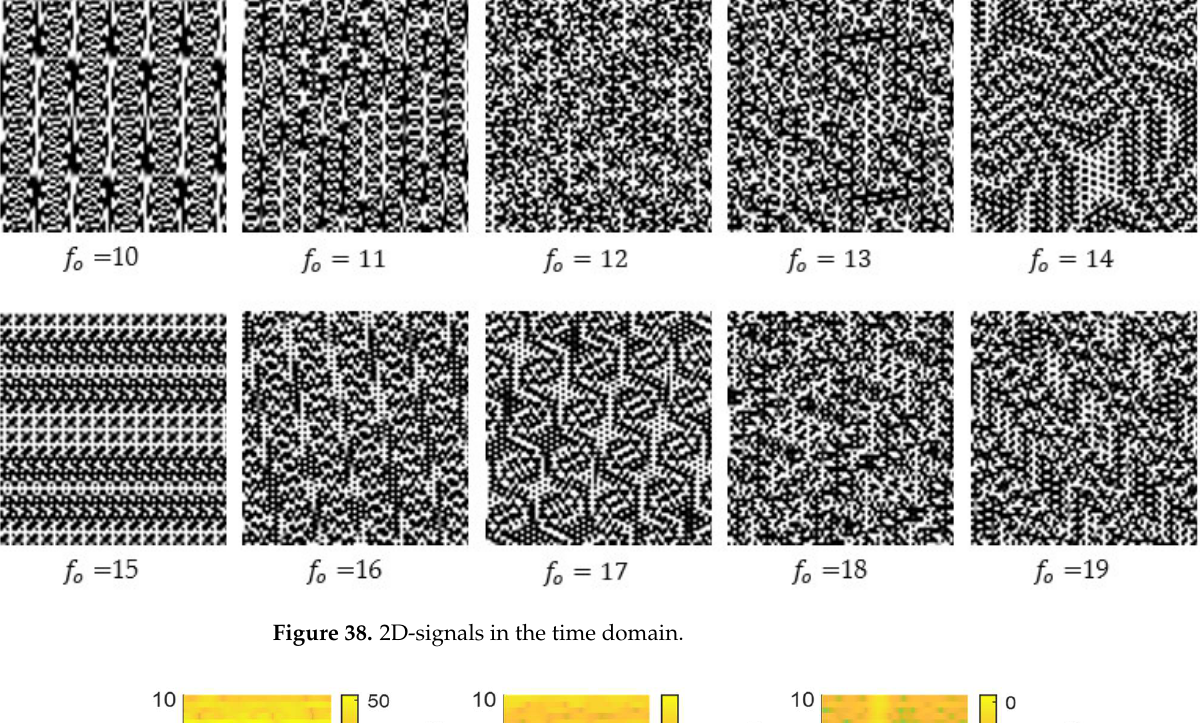
Figure 37. 1D-signals in time domain with different frequency, LCR, and GSNR.